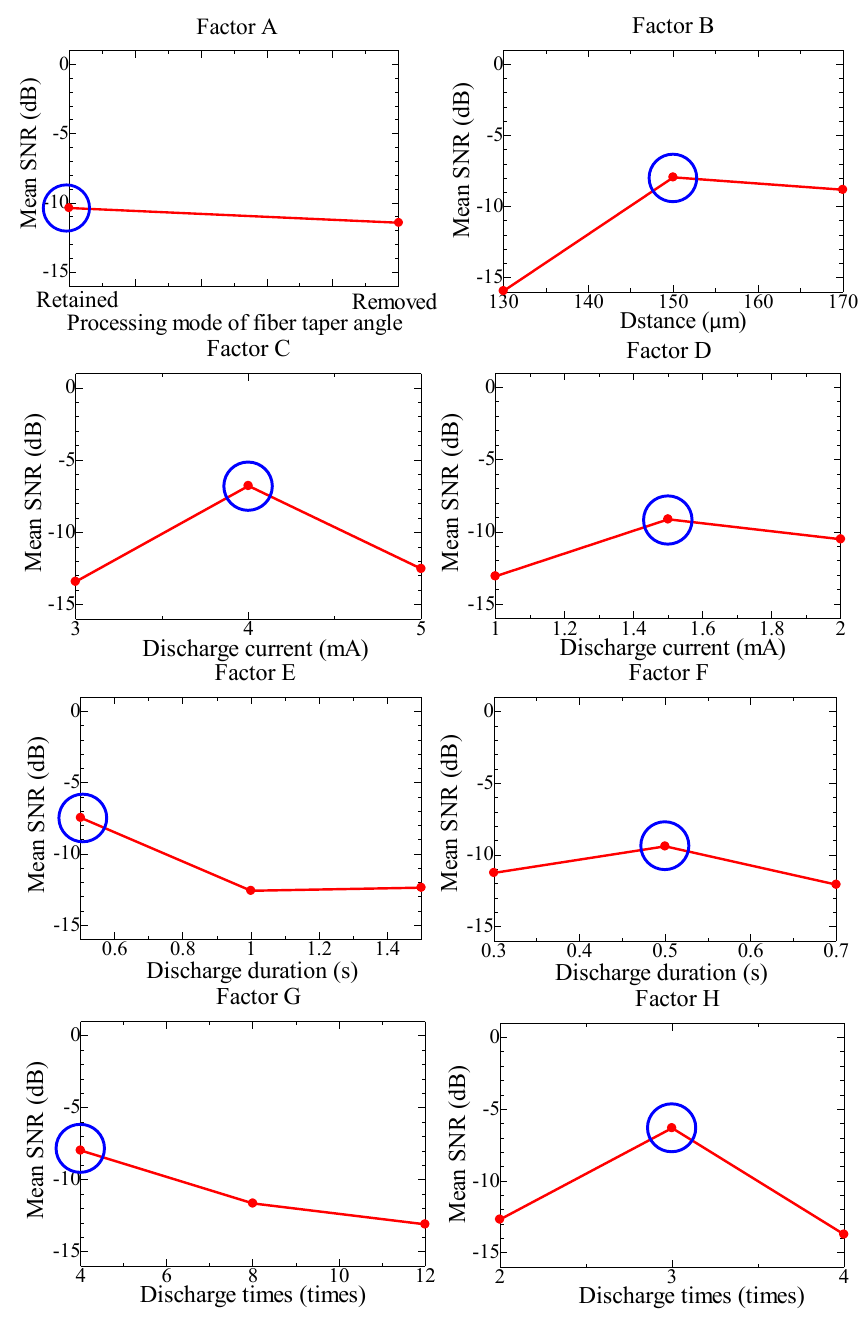
Figure 5. The mean SNR at different levels of process factors for 2D offset